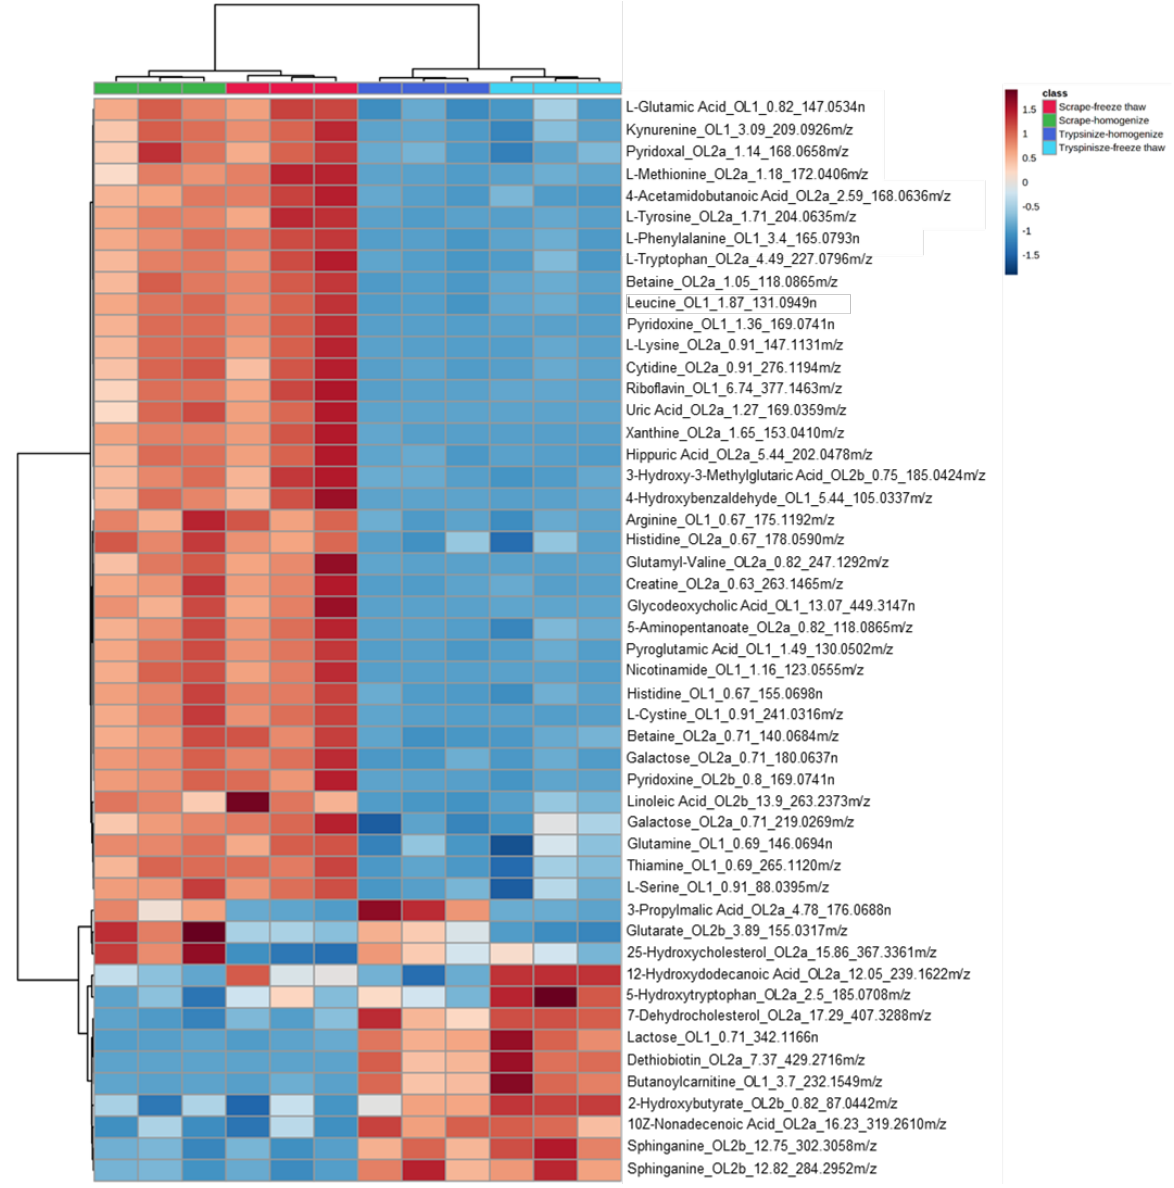
Figure 5. Heatmap of the top 50 metabolites by ANOVA p -value. Signals matched to the in-house library were input into MetaboAnalyst’s “Statistical Analysis” module to generate a heatmap across the different sample preparation methods. Metabolites are displayed in the following format: compound name_ontology level_retention time_mass. Masses ending with n are neutral masses whereas masses ending in m / z are ion masses.